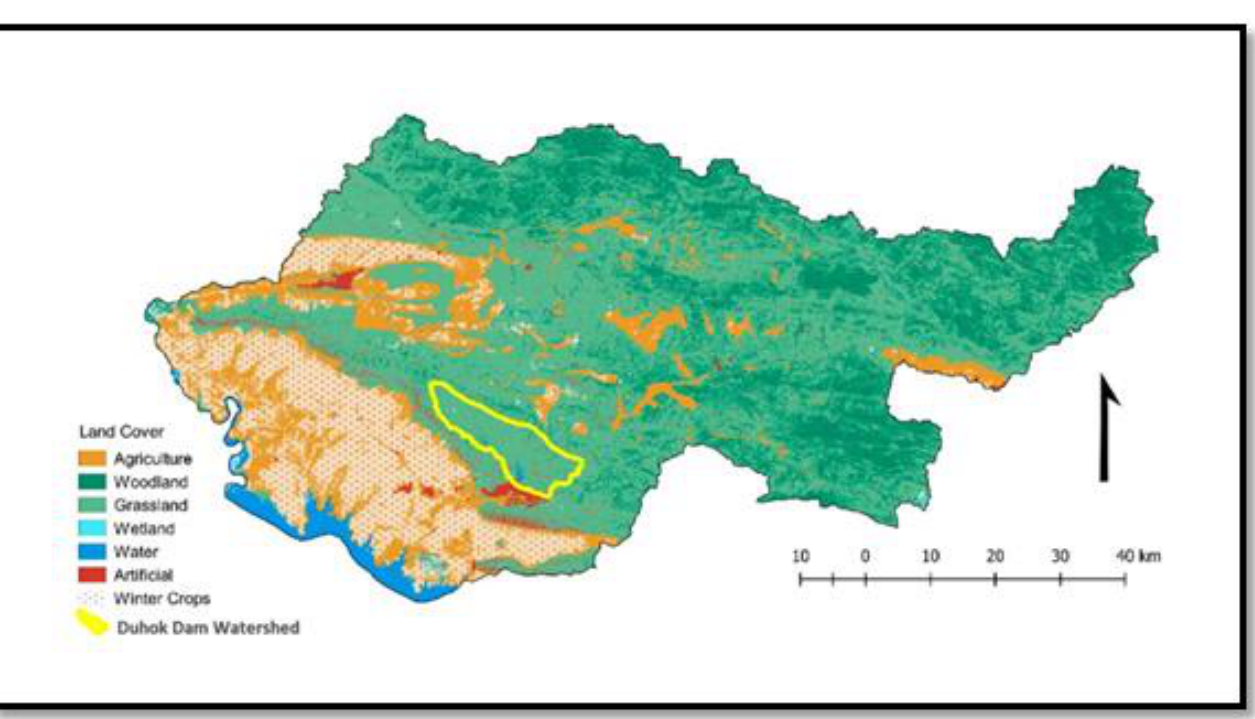
Figure 2. Land cover in the Duhok governorate by 2010 based on Globeland30 (provided by National Geomatics Center of China, DOI:10.11769/GlobeL and 30. 2010.db). Winter crop areas for the period 1998–2014 are superimposed on the land cover